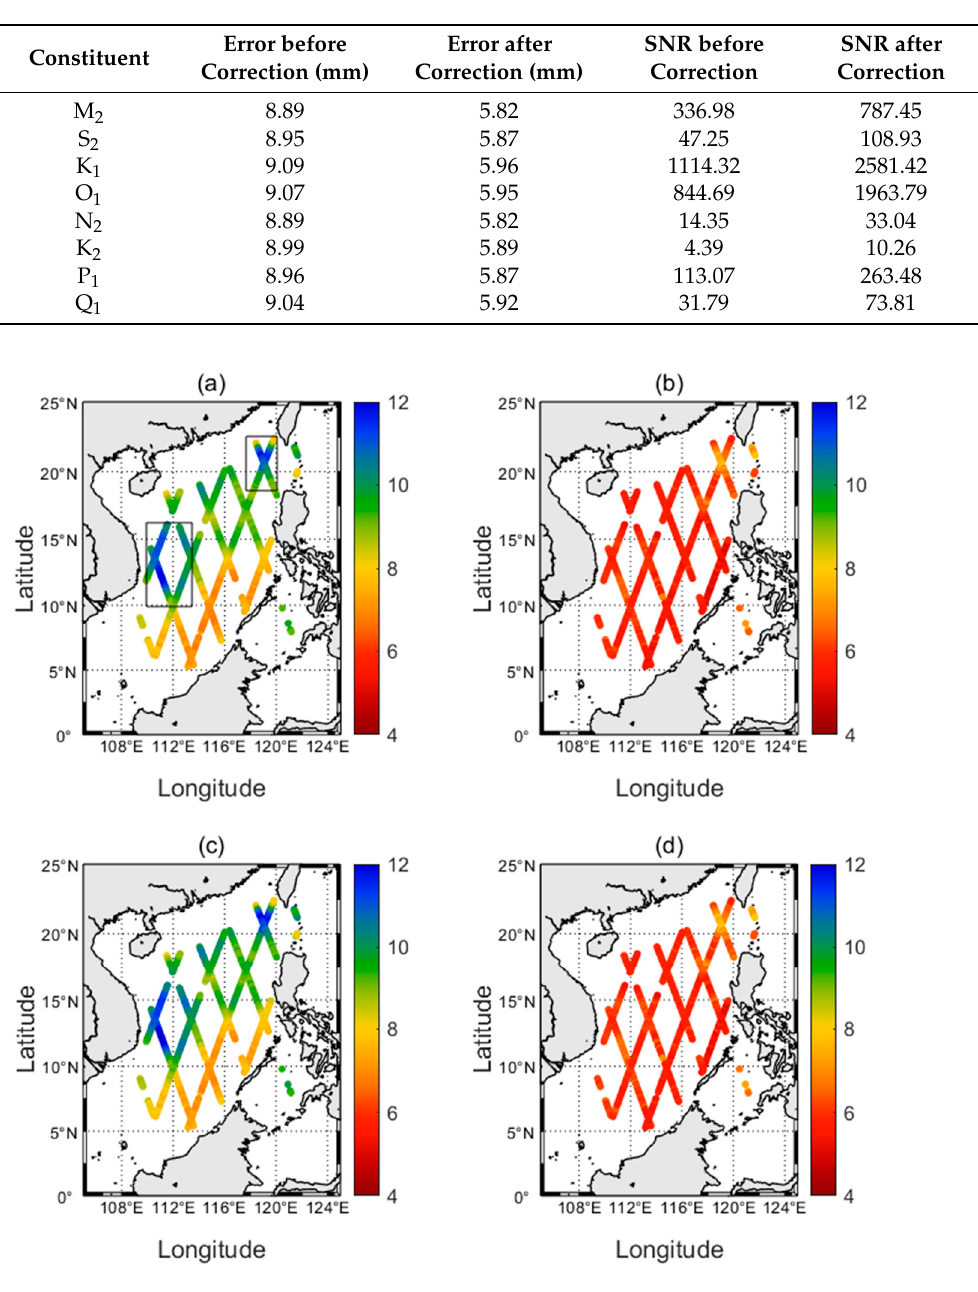
Figure 2. Comparison of estimated error (mm) of M 2 and O 1 constituents before and after the MVC: ( a ) error of M 2 constituent before correction; ( b ) error of M 2 constituent after correction; ( c ) error of O 1 constituent before correction; ( d ) error of O 1 constituent after